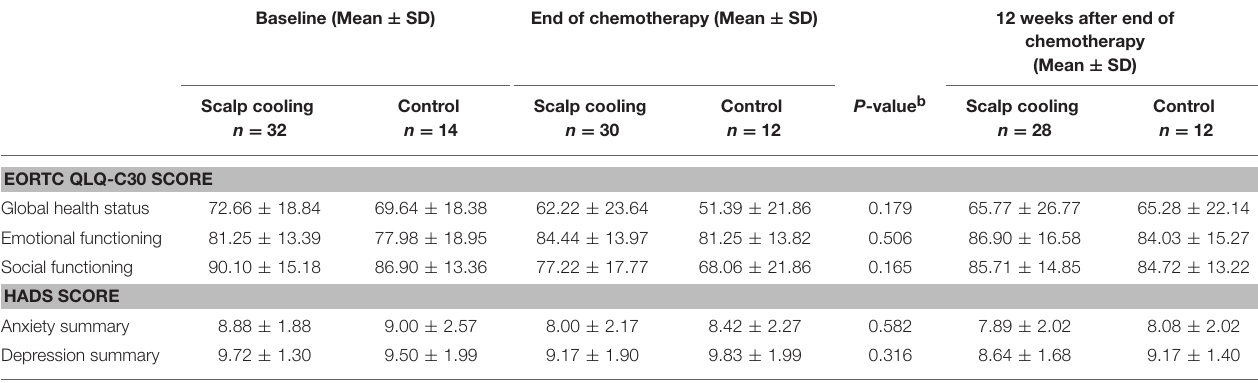
TABLE 4 | Quality of life (ITT population a